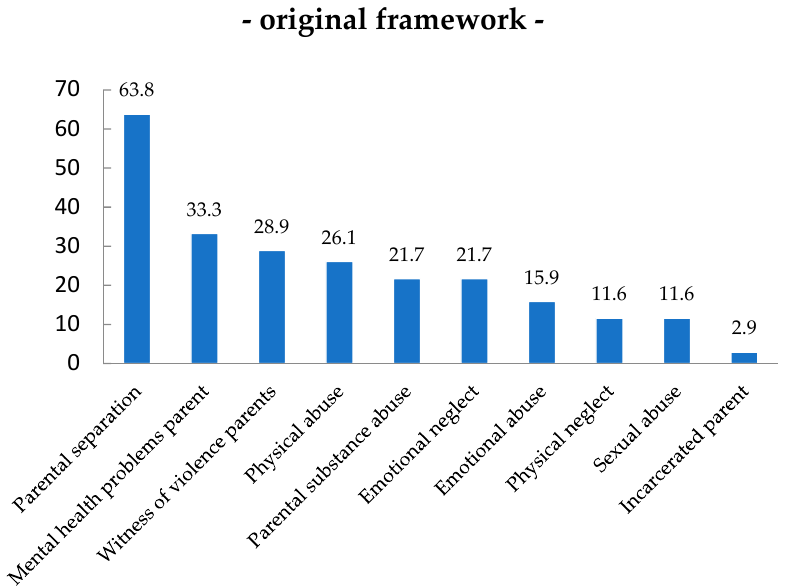
Figure 2. Type of ACEs experienced (%) from the original ACEs framework in children with ID, n = 69.